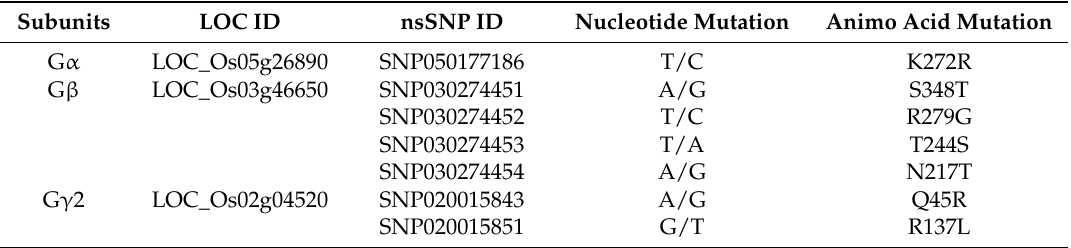
Table 3. nsSNPs in heterotrimeric G protein in rice.